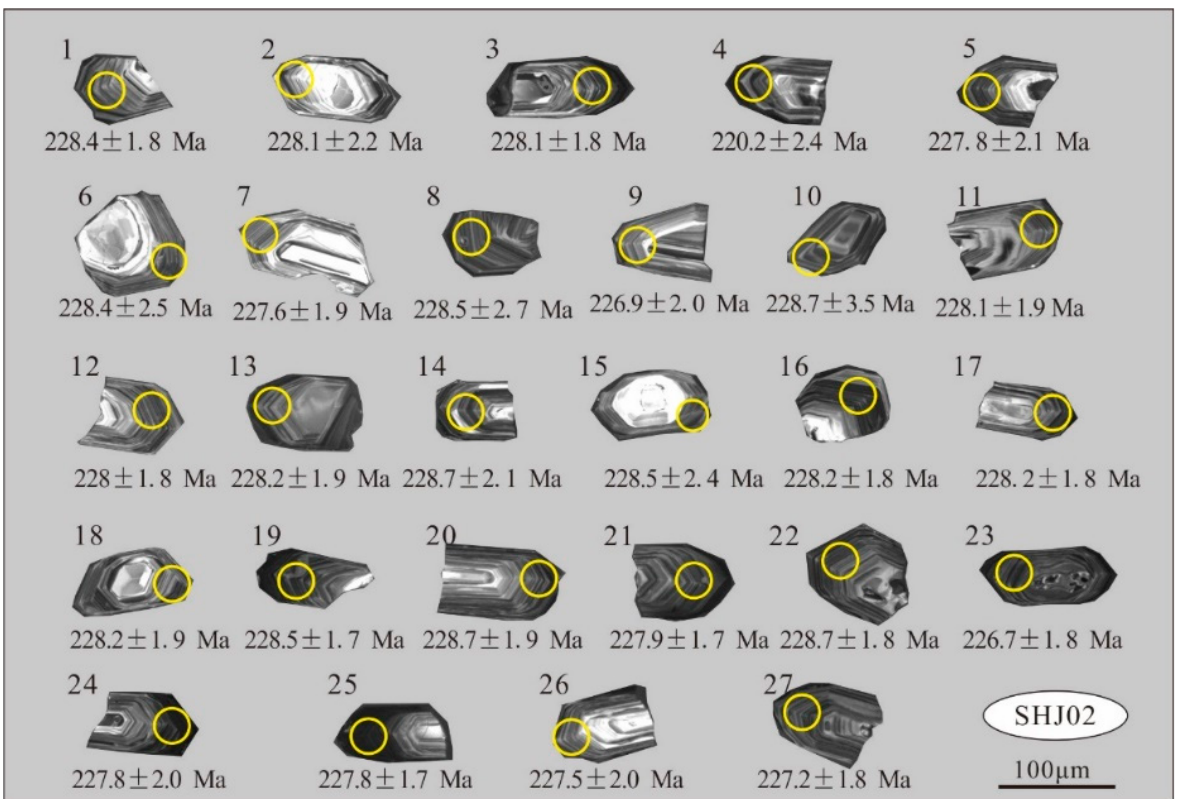
Figure 4. CL images of zircon grains from the Xiangcaoping granite.